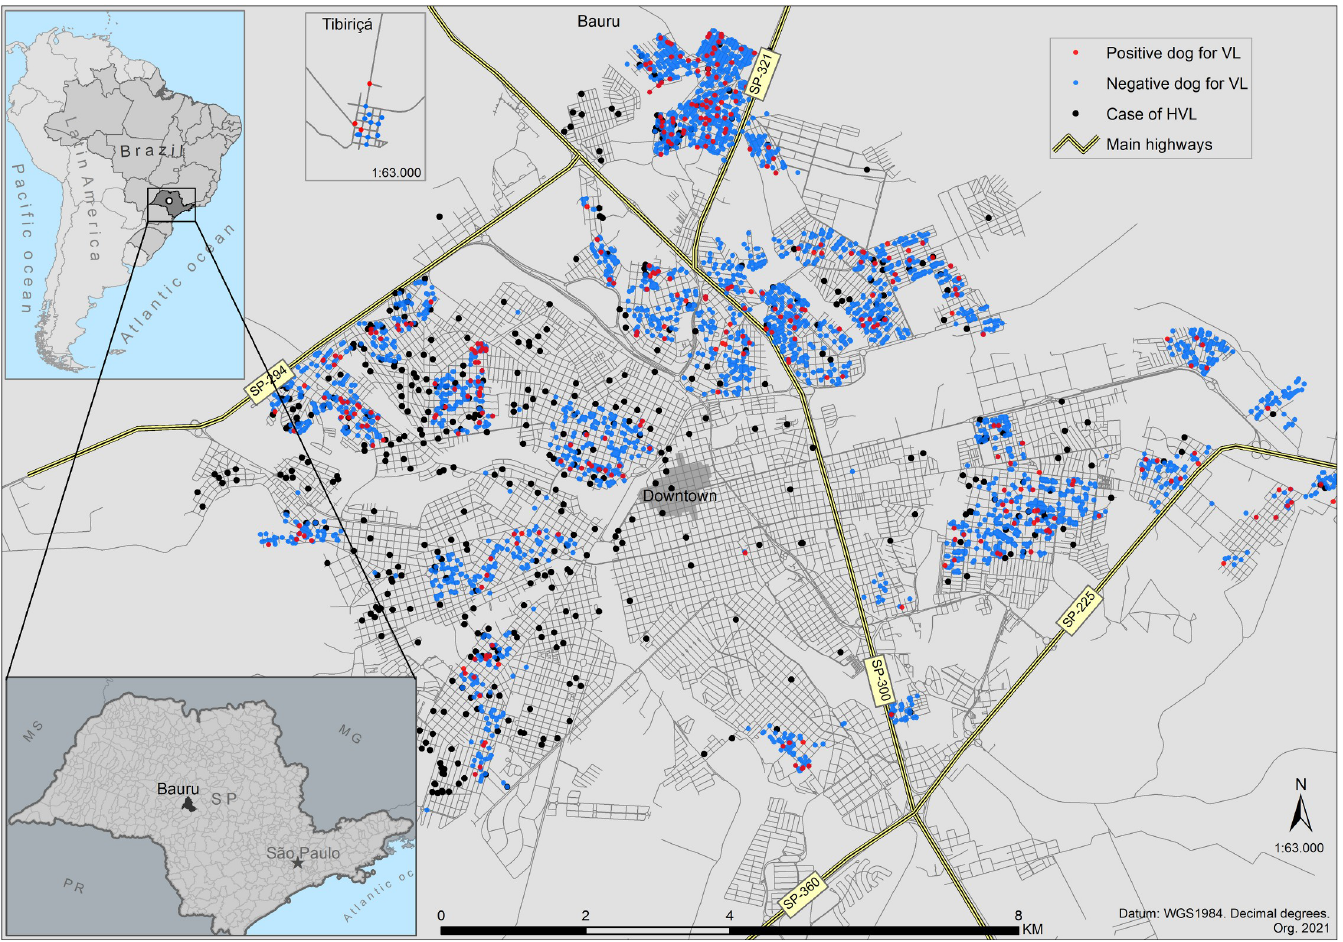
Fig 1. Geospatial location of human cases of VL and the serosurvey in Bauru’s urban area. A total of 6,578 blood samples of dogs were analyzed. Points represent each dog’s address. Positive dogs for CVL are represented by red dots and negative by blue. Black dots are HVL cases. Points are overlapped because of the spatial resolution of the cartographic